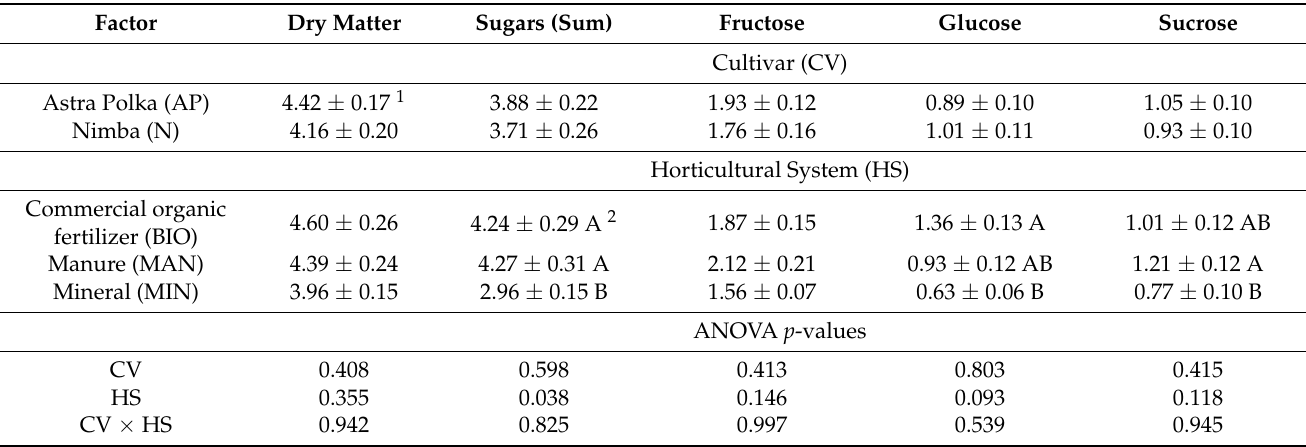
Table 2. The main effect of, and interactions between, cultivar and horticultural system on the content of dry matter, and individual and sum of sugars (g/100 g f.w.) in courgette